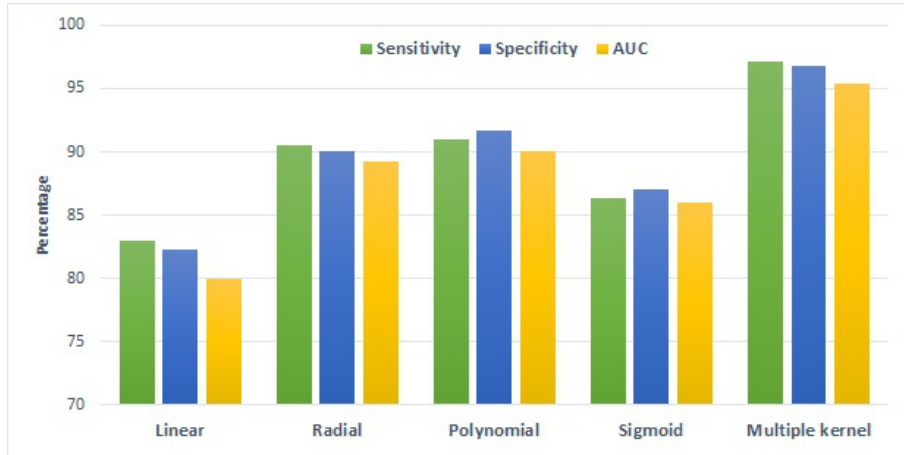
Figure 8. Performance of the proposed approach using multiple kernels and typical kernel functions.